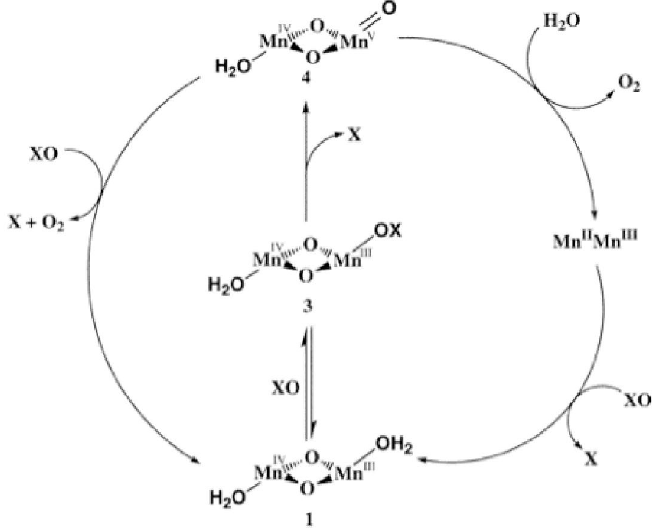
Figure 4. Oxygen evolution mechanism of Mn-terpy dimer in the presence of chemical oxidant, XO. Left pathway: attach of XO on the terminal oxo ligand. Right pathway: attack of solvent water on the terminal oxo ligand. (from reference [42], produced with permission from the American Chemical